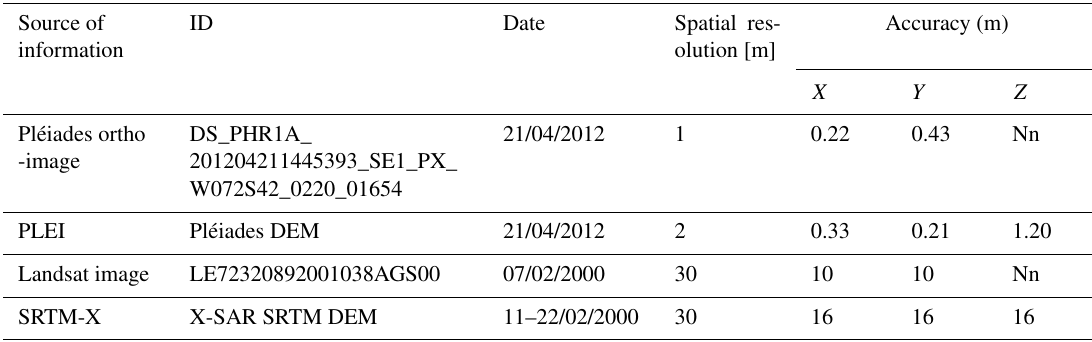
Accuracy (m) olution [m] X Y Z